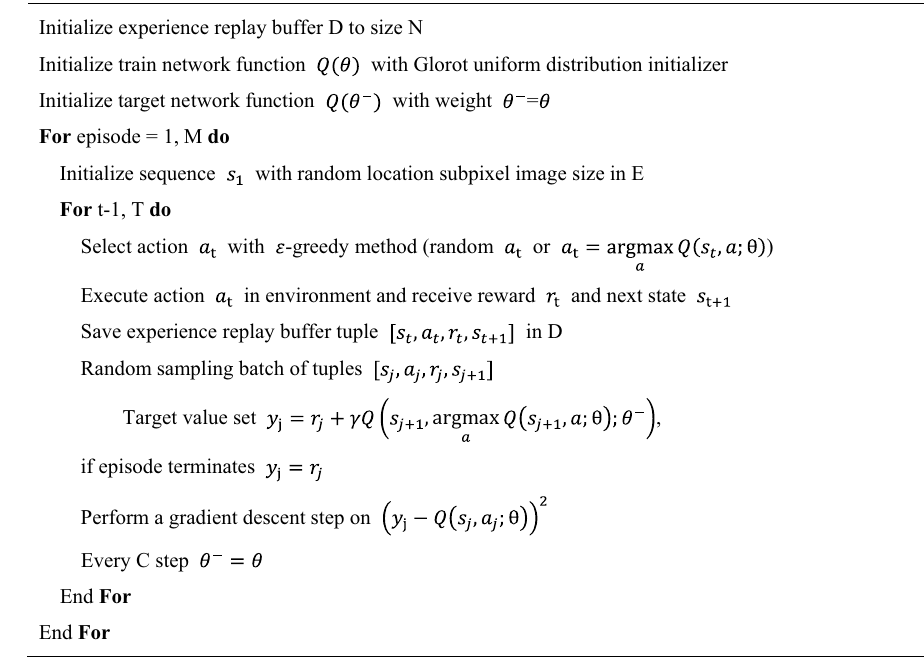
Algorithm 1. Training step of DRL for cephalometric landmark